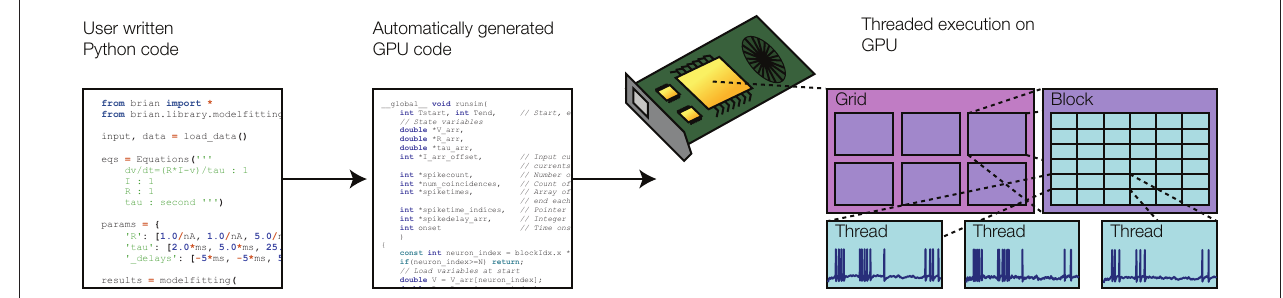
Figure 3 | Simulation on graphics processing unit (gPu). Model code is transformed into GPU-executable code and compiled at runtime. The GPU simulates the neurons with one execution thread per neuron, each with a specific set of parameter values. GPU threads are organized into blocks, and blocks are organized into grids. The division into blocks and grids controls the memory access patterns in the GPU hardware.